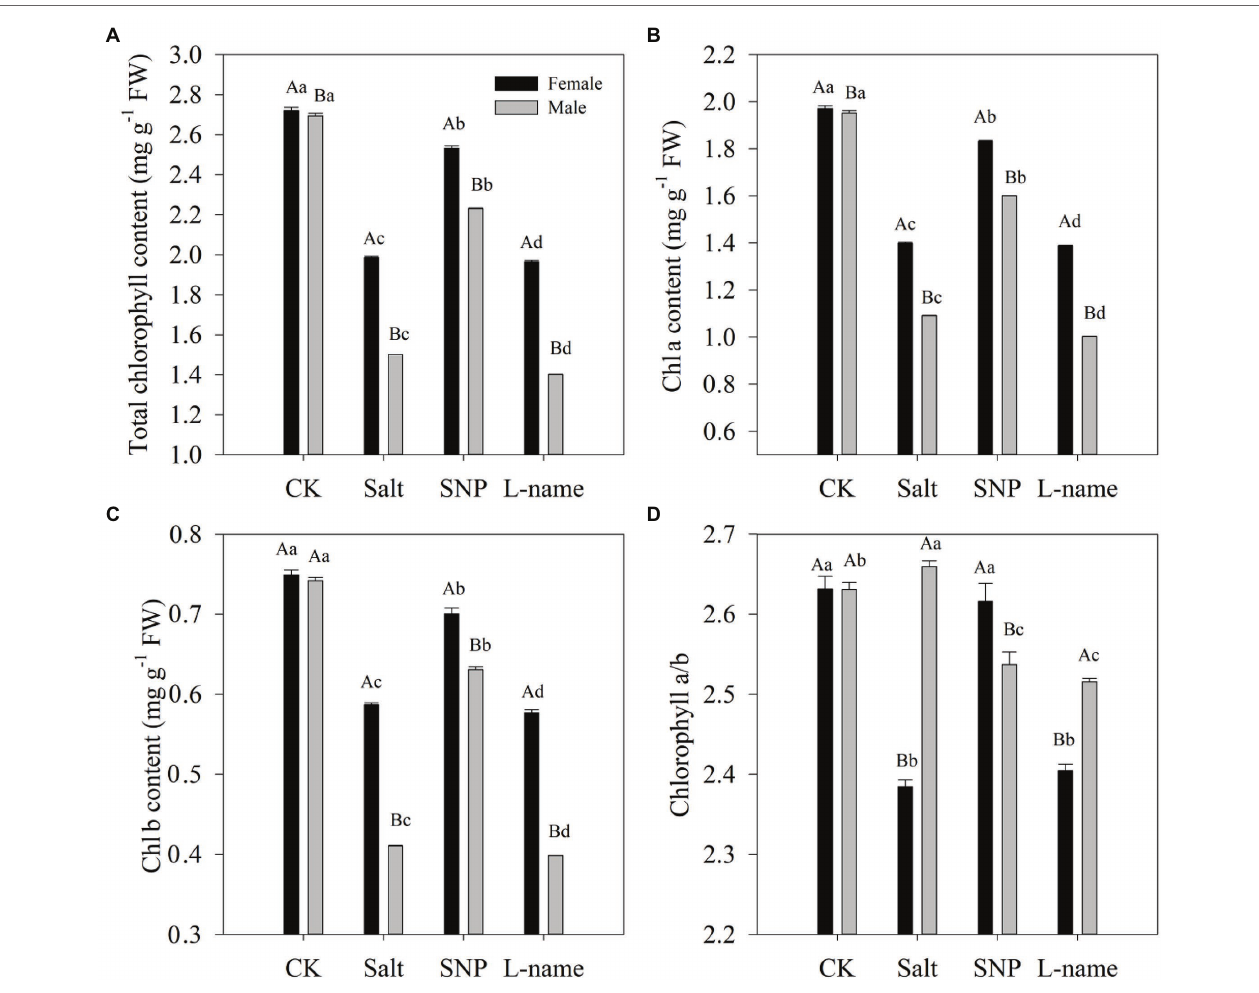
FIGURE 1 | Photosynthetic pigment contents [total chlorophyll content (A) , Chl a content (B) , Chl b content (C) , and ratio of Chl a to Chl b (D) ] measured in T. grandis in response to different treatments. CK (control, distilled water), salt (100 mM NaCl), SNP (100 mM NaCl with 0.05 mM SNP), and L-name (100 mM NaCl with 0.5 mM SNP and L-name). Different uppercase letters indicate a significant difference between different genders at p < 0.05, and different lowercase letters indicate significant difference under salt treatment at p < 0.05, according to Duncan’s